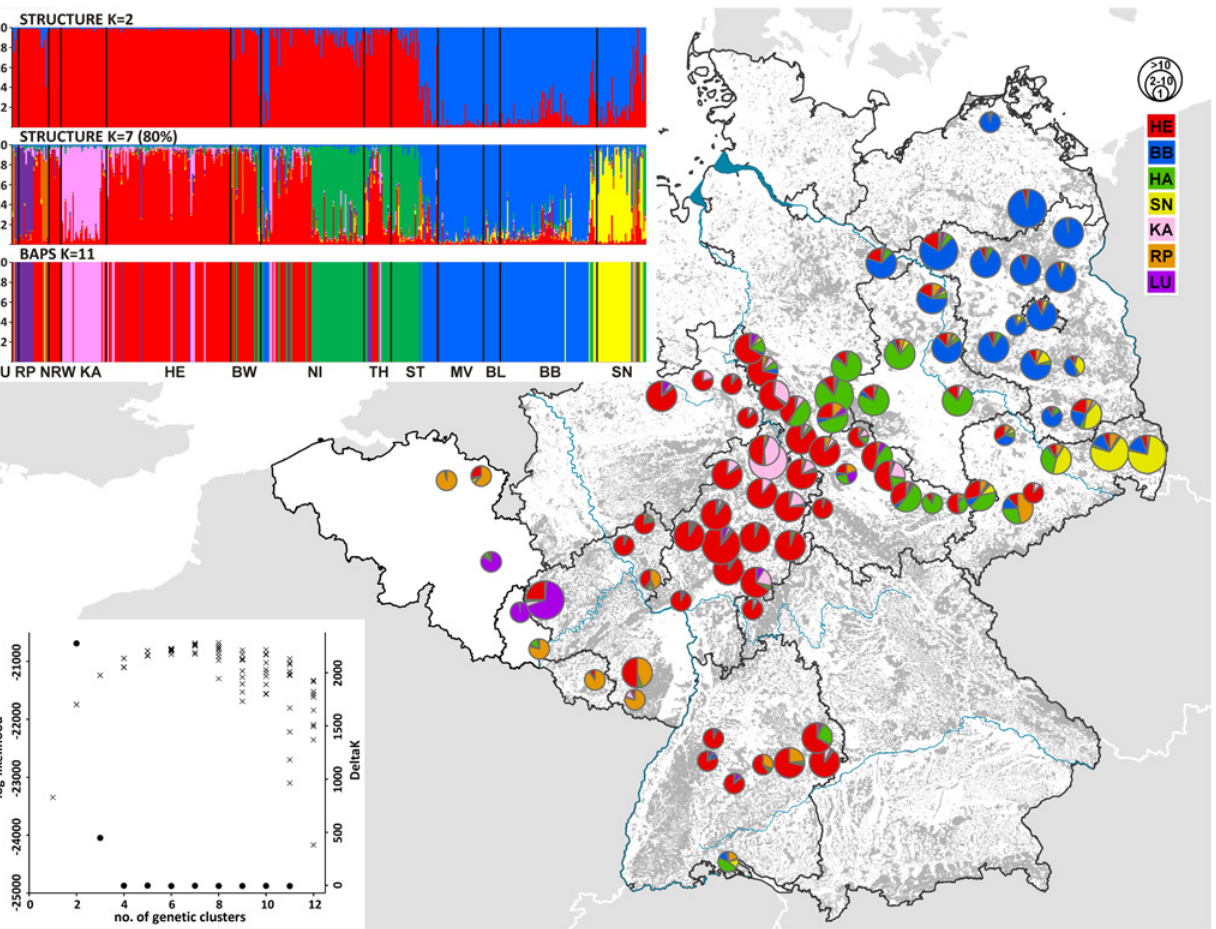
Fig 2. Geographic distribution of the STRUCTURE clusters ( K = 7) for all 407 samples. The pre-defined populations correspond to the federal states of Germany. Pie charts represent the average per cluster assignment values for all the individuals in an administrative district and their size is indicative of the number of samples included. Light blue lines represent major rivers, grey pattern indicate forests. Top inset: Summary of the assignment analysis in STRUCTURE ( K = 2, K = 7) and BAPS (K = 11). Each individual is represented by a single vertical line, representing the individual`s estimated proportion of membership to the genetic cluster. Colours correspond to the clusters in the main figure. The five BAPS-clusters of one to three individuals were coloured in different orange shades. Single samples from BY, SH and SL were included in the adjacent state. Bottom insert: Plot of the number of STRUCTURE clusters tested against their estimated log-likelihood (x) and DeltaK ( (cid:129)